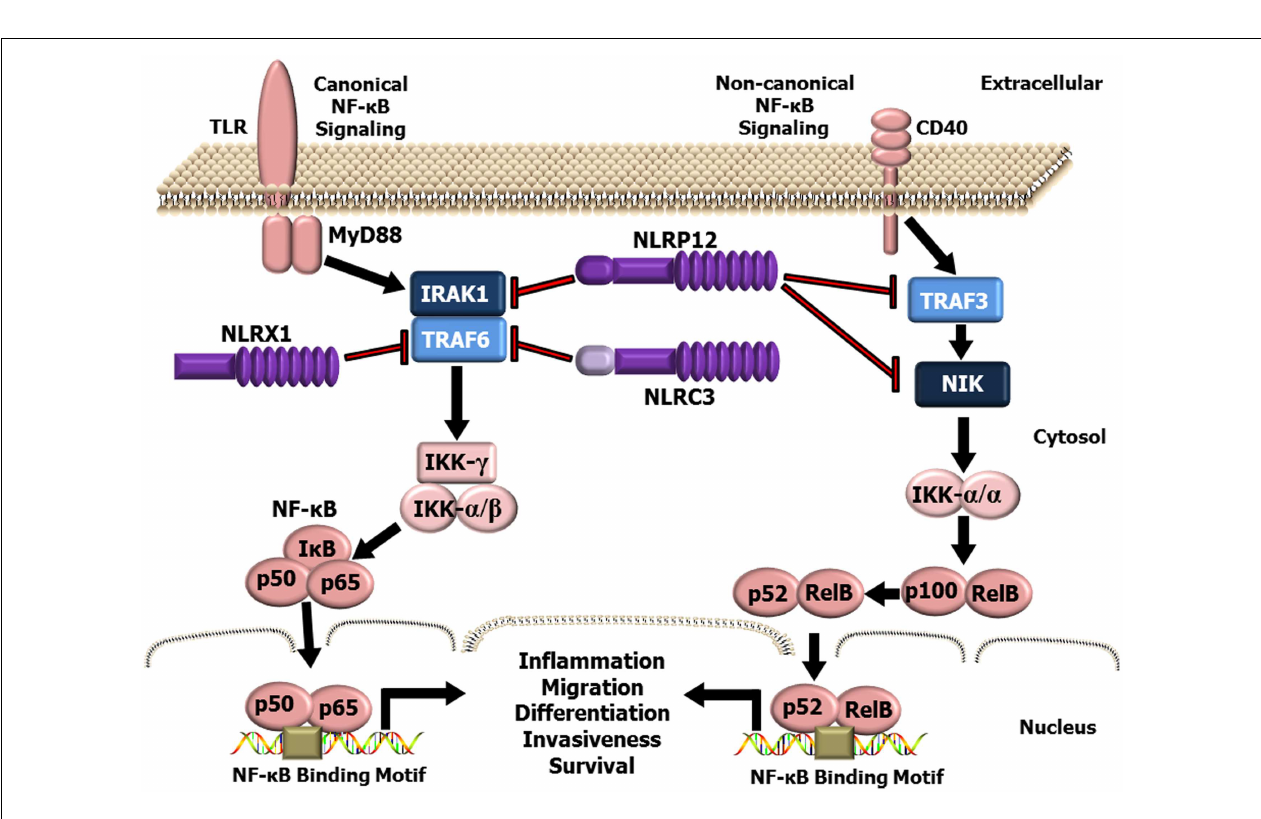
stimulation. Likewise, NLRC3 was also shown to interact withTRAF6 and attenuate NF- κ B signaling through a similar mechanism. NLRP12, has been shown to attenuate both the canonical NF- κ B signaling pathway through modulating the phosphorylation of IRAK-1 and the non-canonical NF- κ B pathway through interactions withTRAF3 and